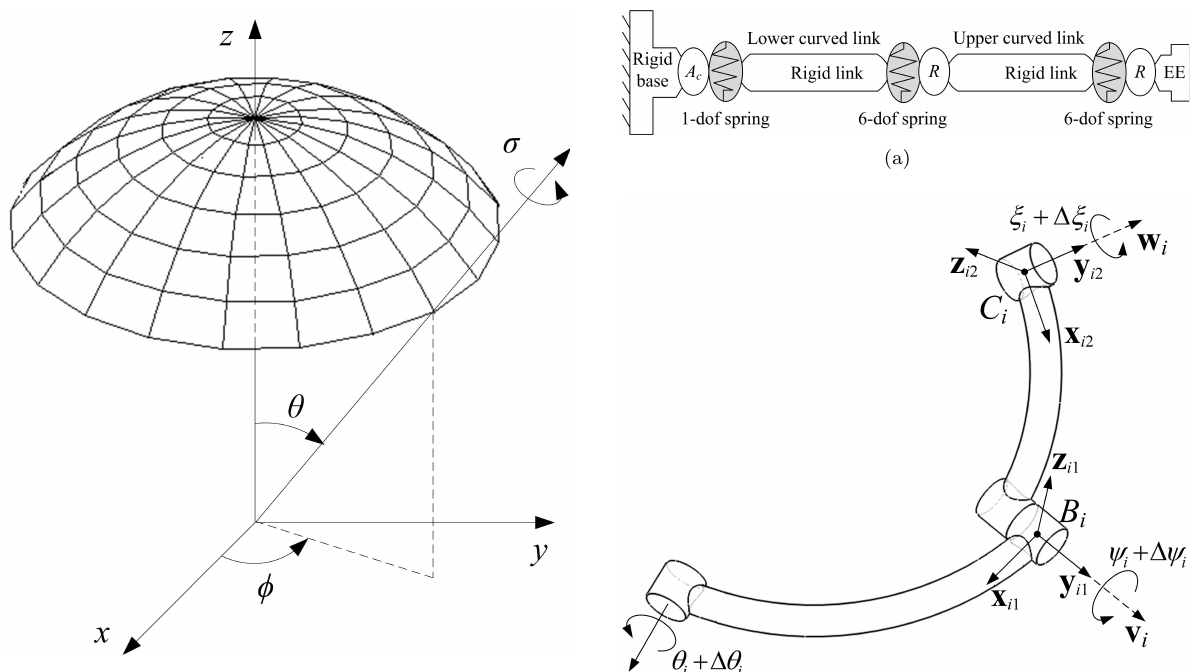
Figure 3: The orientation representation of the azimuth–tilt–torsion angles.